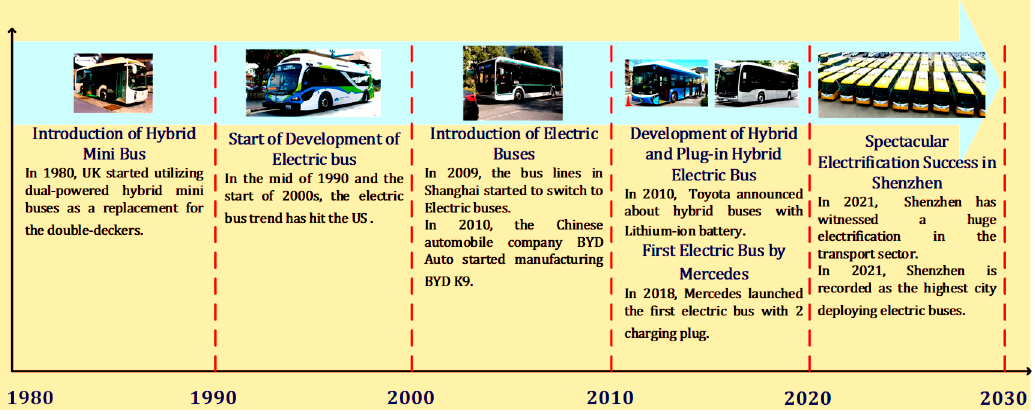
Figure 1. Evolution of Electric Buses [4].